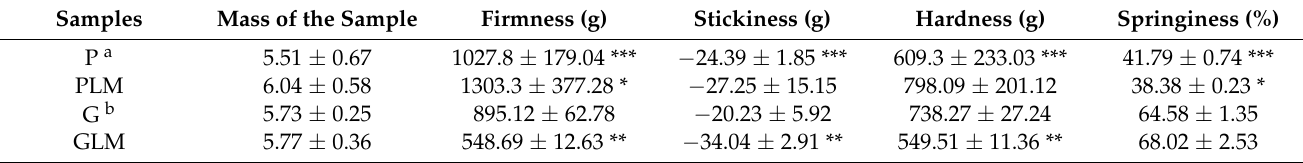
Table 6. Chewable gel tablets texture properties depending on the